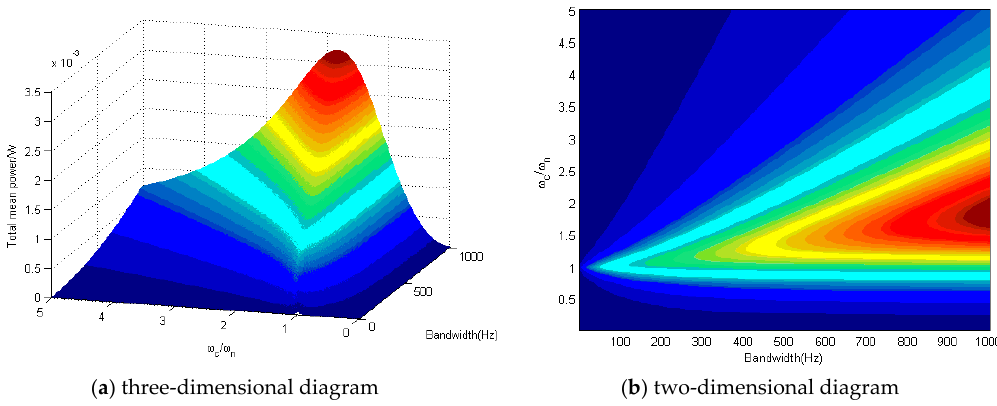
Figure 8. Total mean power of nonlinear hybrid energy harvester with different excitation bandwidths and center frequencies.